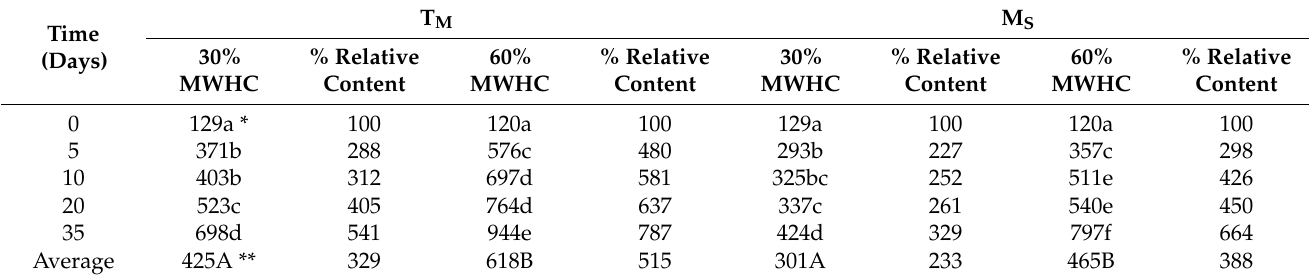
Table 8. Effect of incubation time and soil moisture on EC value ( µ S cm − 1 ) of soil solution under incubation of organic